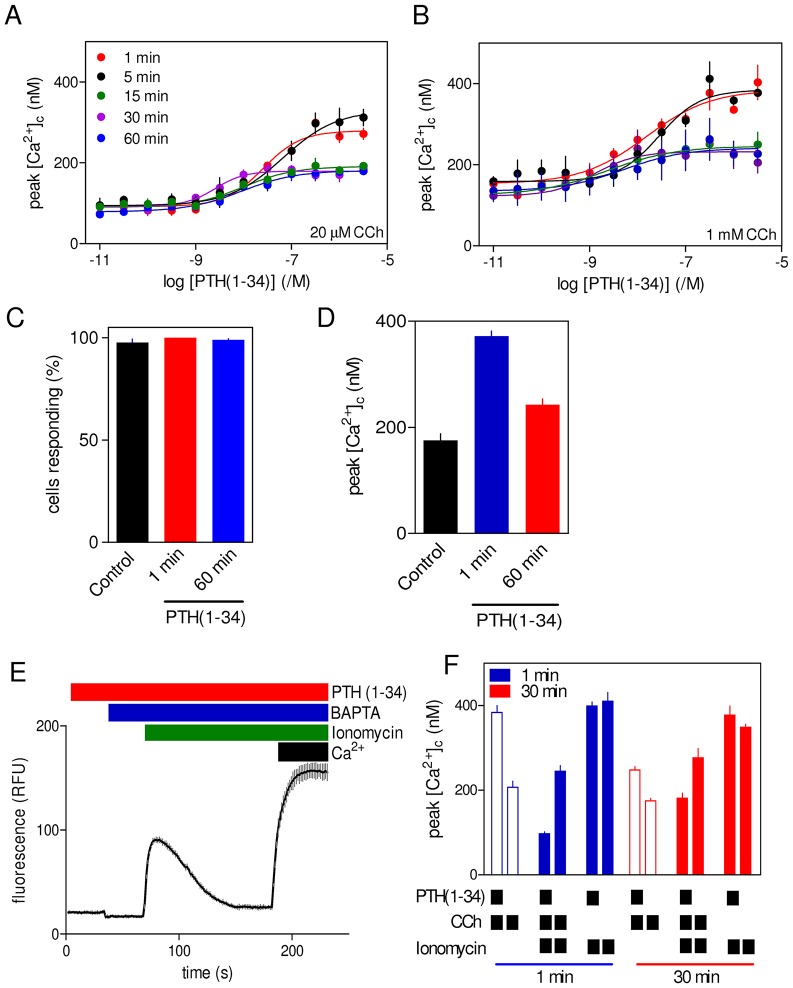
Sustained stimulation with PTH(1-34) reduces potentiated carbachol-evoked Ca2+ signals without affecting the Ca2+ content of the intracellular stores. (A,B) Populations of HEK-PR1 cells were incubated with the indicated concentrations of PTH(1-34) for 1–60 min in HBS before addition of BAPTA (2.5 mM) and either 20 µM (A) or 1 mM carbachol (CCh) (B). The code in A applies to both panels. Results in A and B are mean±s.e.m., n = 4. (C,D) Single-cell analyses show the percentage of cells in which carbachol (1 mM) evoked a detectable increase in [Ca2+]c in control cells or after stimulation with PTH(1-34) (100 nM) for 1 or 60 min (C), and the increase in [Ca2+]c evoked by carbachol under each condition (D). In these experiments, normal HBS was replaced by nominally Ca2+-free HBS 5 min before addition of carbachol. Results in C and D are from three coverslips each with ∼65 cells and are presented as mean±s.e.m. (E) The effect of prolonged stimulation with PTH(1-34) on the Ca2+ contents of the intracellular stores was assessed by incubating populations of cells with PTH(1-34) for 30 min, before addition of BAPTA (2.5 mM) and then ionomycin (1 µM). Restoration of extracellular Ca2+ (10 mM) at the end of the experiment confirmed that the indicator was not saturated by the Ca2+ signals evoked by ionomycin. Results show a typical trace from five wells in one experiment. RFU, relative fluorescence units. (F) Similar experiments to that shown in E showing the effects of treatment for 1 or 30 min with PTH(1-34) (100 nM) on the peak Ca2+ signals evoked in Ca2+-free HBS by carbachol (20 µM, unfilled bars) or ionomycin (1 µM, solid blue and red bars) with or without prior carbachol treatment. Results are mean±s.e.m., n = 3.